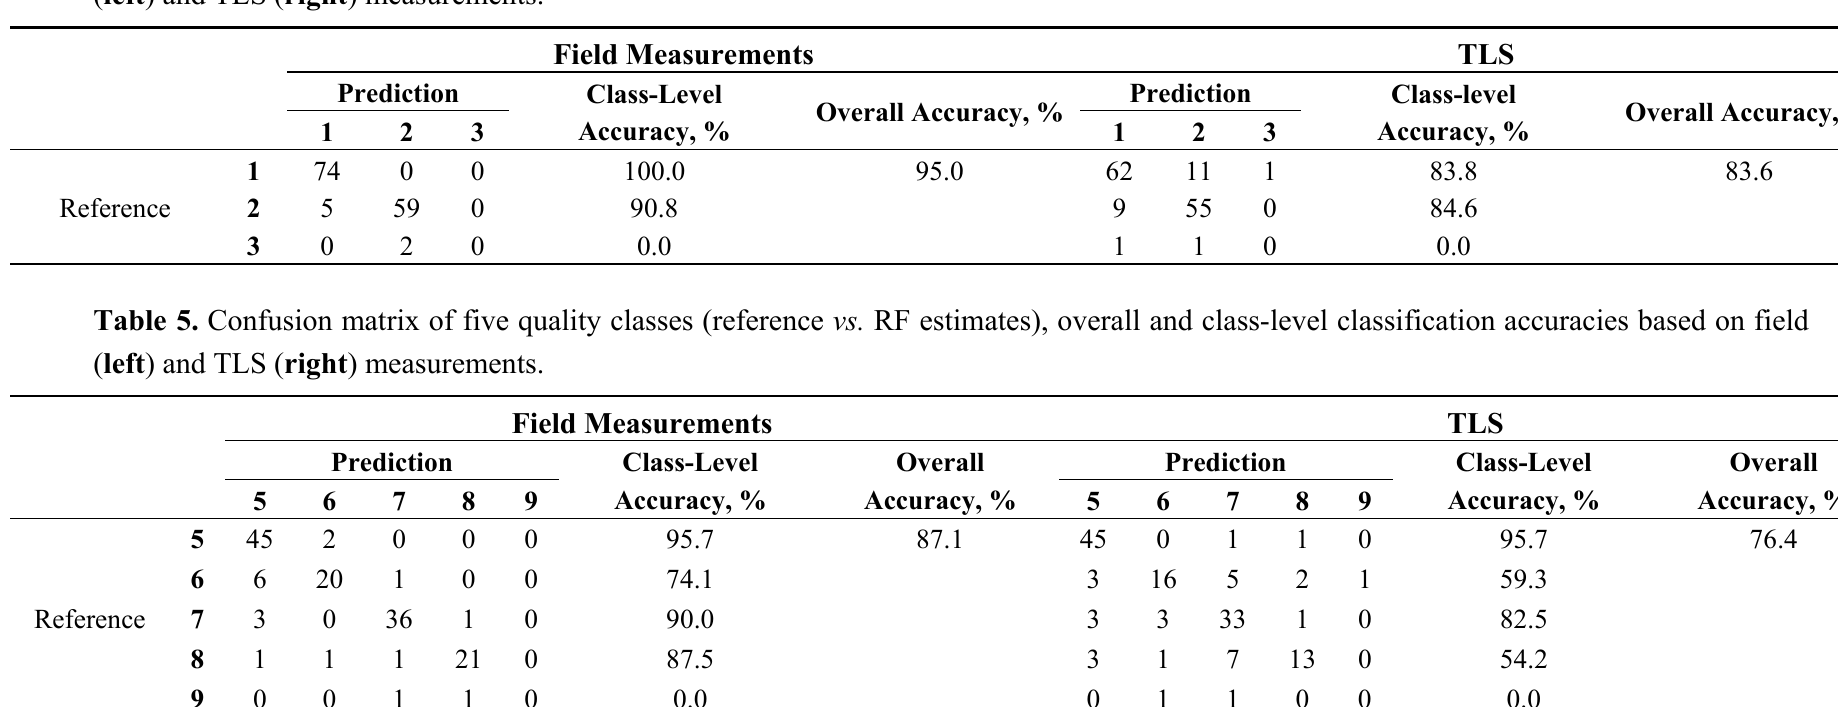
Table 4. Confusion matrix of three quality classes (reference vs. RF estimates), overall and class-level classification accuracies based on field ( left ) and TLS ( right ) measurements.